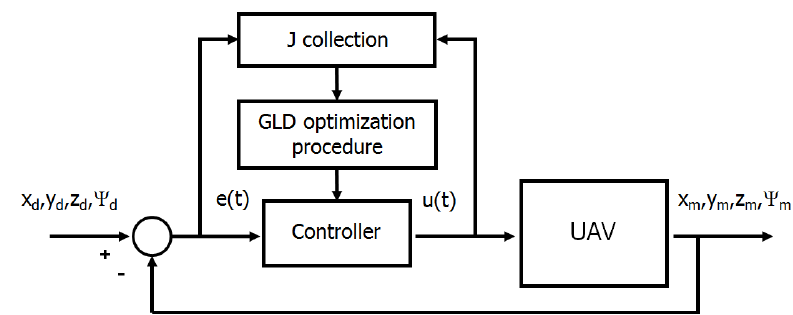
Figure 2. Diagram of considered control system.